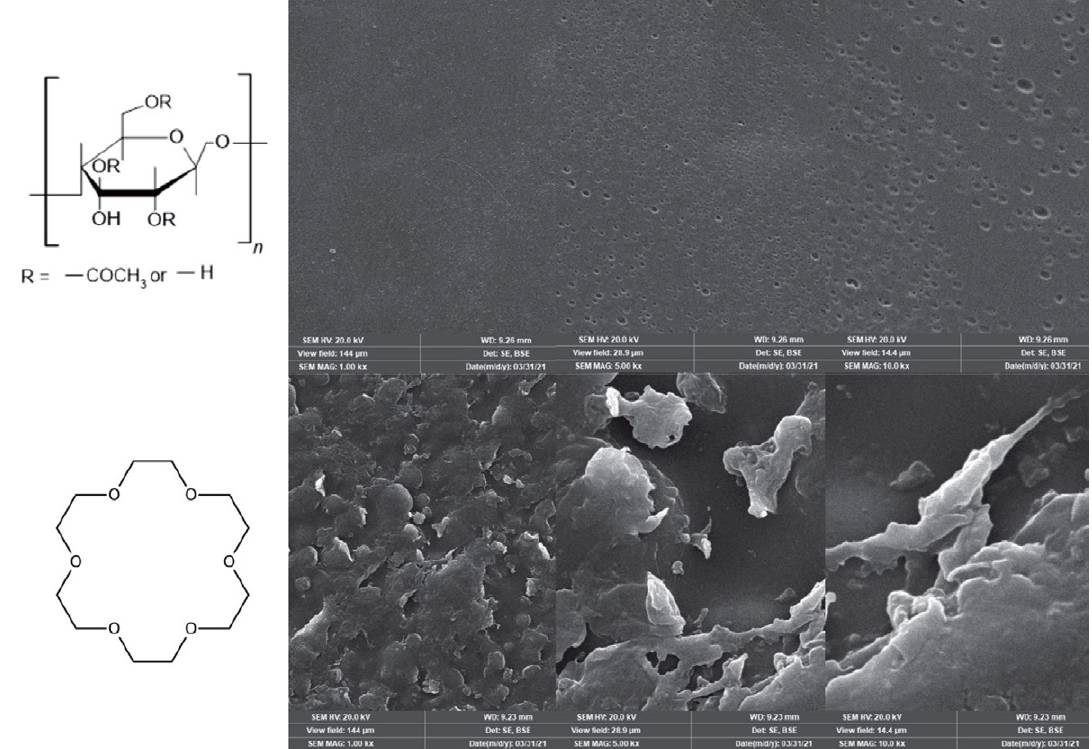
Figure 3: The micrographs of the acetyl cellulose film (the upper row) and the film with the addition of 15% ether 18-crown-6 (the lower row) are compared at various